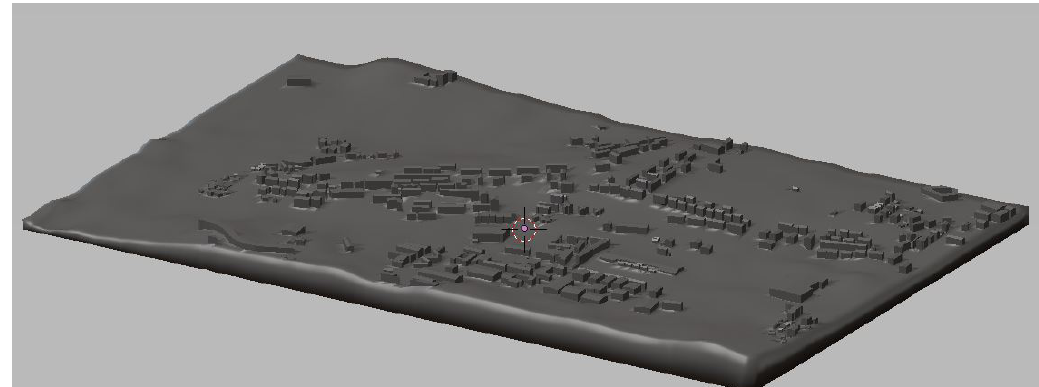
Figure 3. Model as a solid, ready to export to create the physical model.